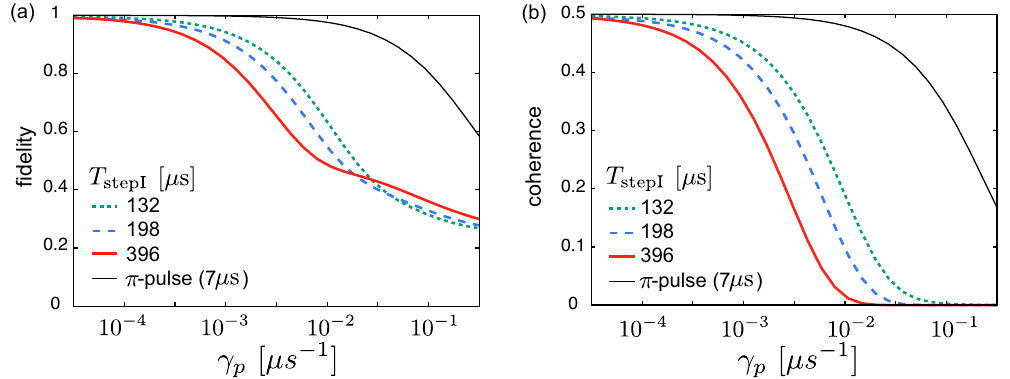
Figure 9. Dependence of the fidelity ( a ) and the coherence ( b ) at t = T stepI on γ p for the π -pulse and the invariant-based engineering